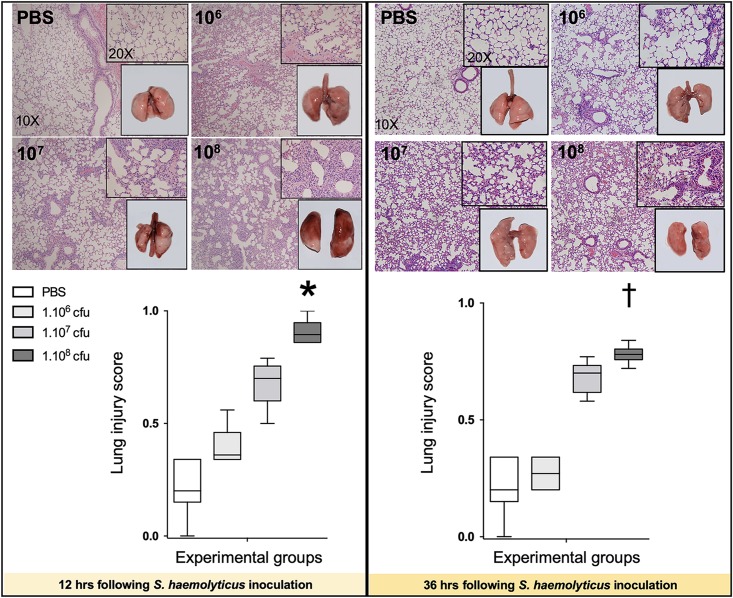
Macroscopic (square windows) and histological lung aspects 12 and 36 h following tracheal inoculation of PBS, and live S. haemolyticus at 106, 107, and 108 CFU. Lung injury score (LIS) is represented as median values and interquartile 25th–75th range and extreme values (>2 SD). Twelve and 36 h after inoculation, LIS was significantly different between groups: Kruskal–Wallis p = 0.0002; ∗indicates p < 0.05 for 108 CFU versus PBS and 106 CFU; †indicates p < 0.05 for 108 CFU versus PBS and 106 CFU. Twelve and 36 h after tracheal inoculation of 106 and 107 CFU, interstitial pneumonia is present, characterized by inflammatory cells infiltrating interalveolar septa and respecting alveolar space and lung architecture. Twelve and 36 h after tracheal inoculation of 108 CFU, confluent pneumonia is present, characterized by inflammatory cells invading alveolar space, hyaline membranes, lung consolidation, and loss of basal lung architecture.